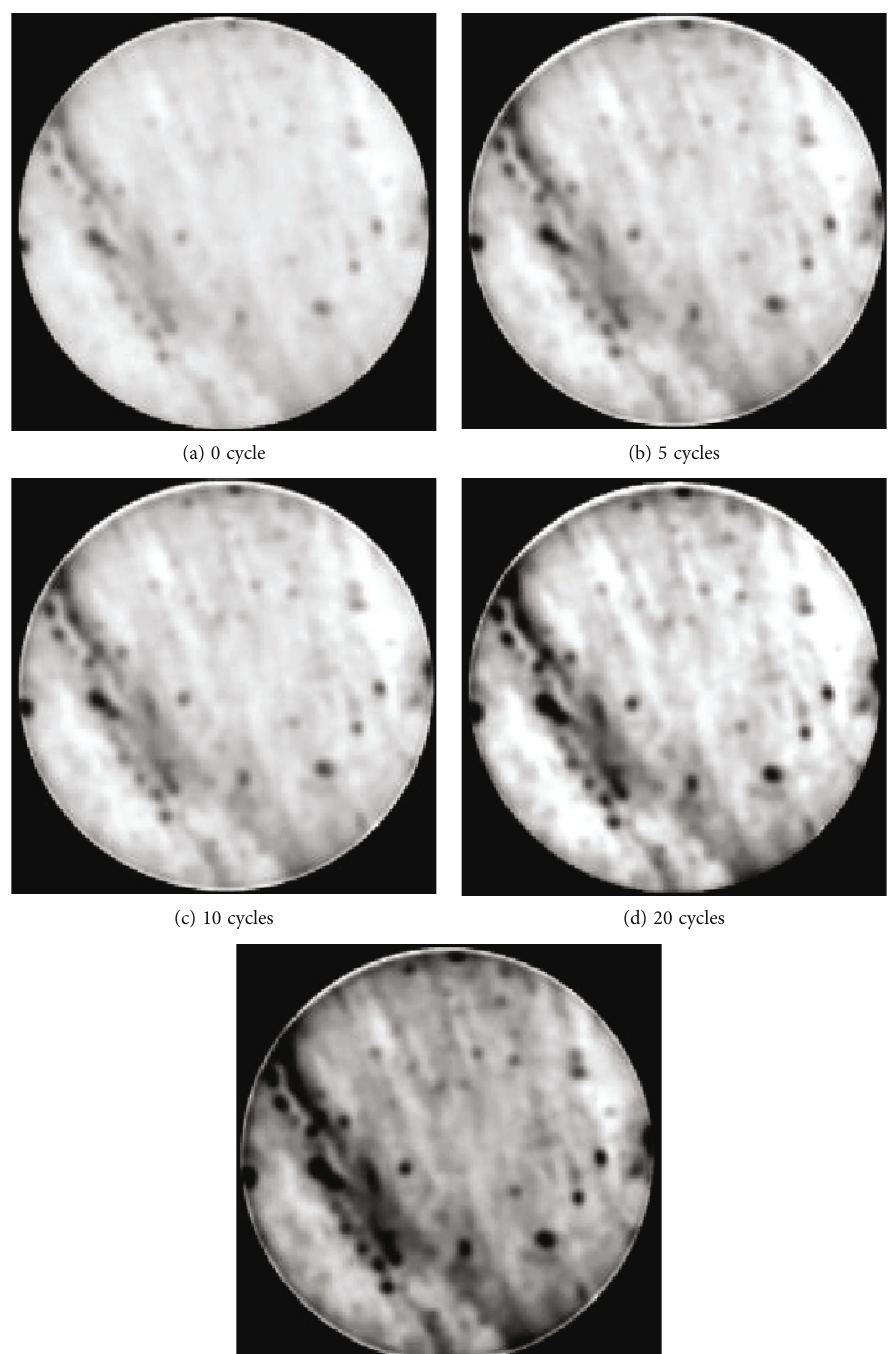
Figure 3: CT images of sandstone under di ff erent freeze-thaw